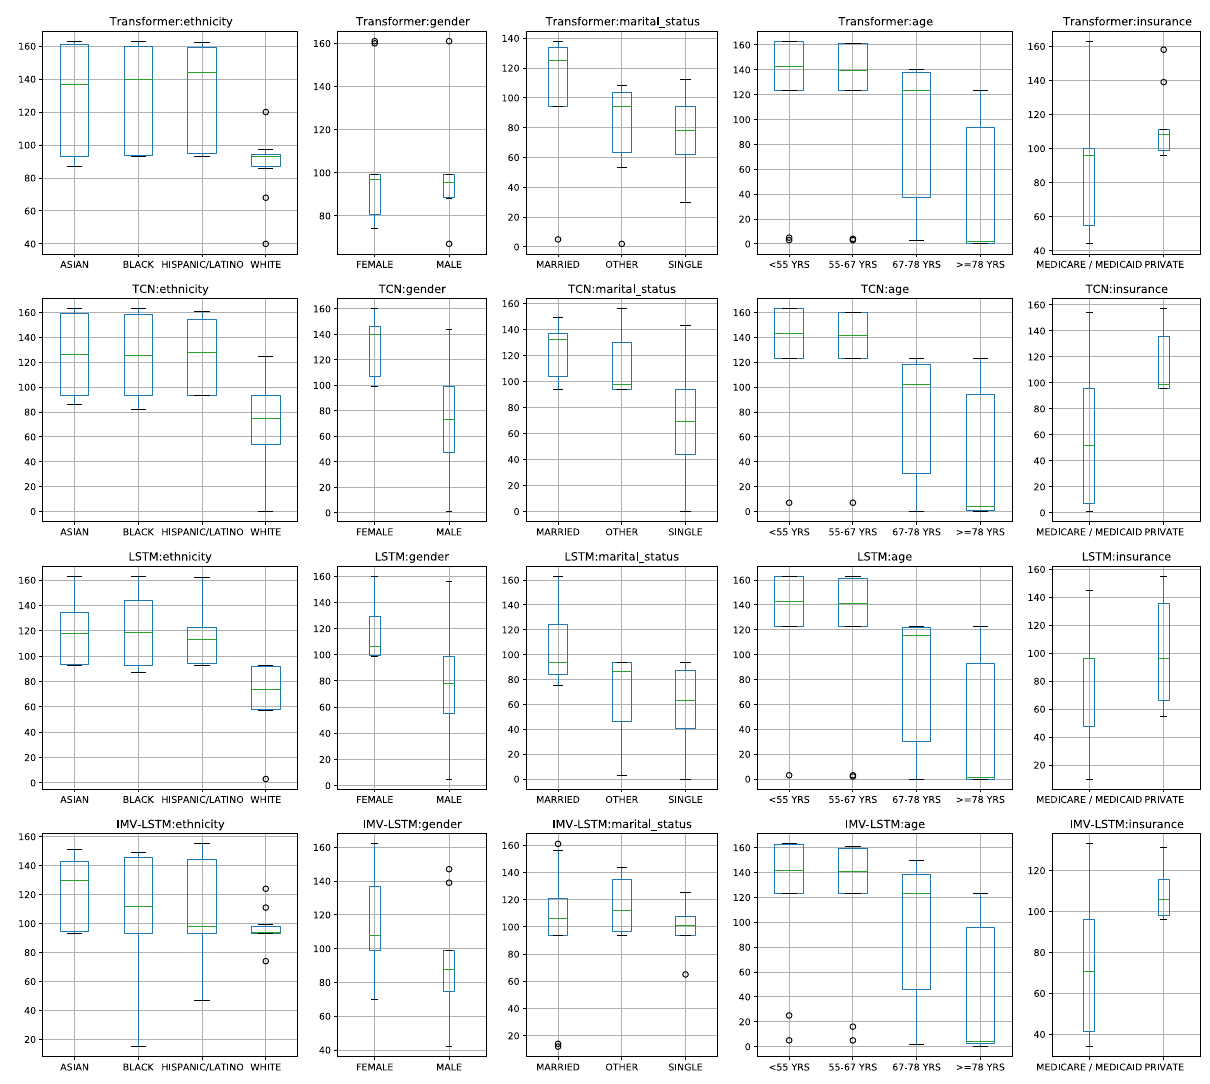
Figure 7. Feature rankings for each demographic feature for the four models: Transformer, TCN, LSTM, and IMV-LSTM, and each of the 12 interpretability methods: ArchDetect, DeepLiftShap, FeaturePermutation, IntegratedGradients, SaliencyNoiseTunnel, DeepLift, FeatureAblation, GradientShap, Occlusion, Saliency, and